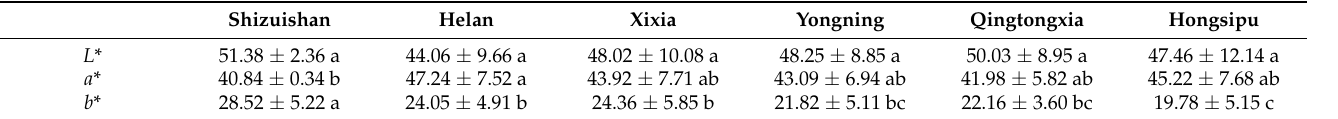
Table 2. Color parameters of Cabernet Sauvignon wines from the six sub-regions of EFHM. Shizuishan